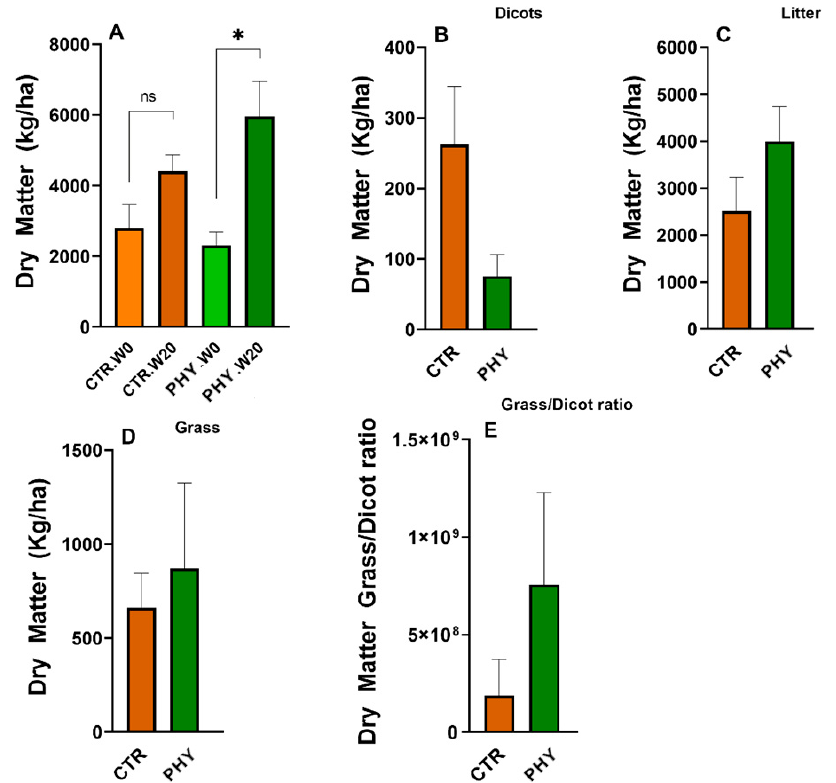
Figure 8. Dry matter differences between phytogenic liquid-treated and control plots. Panel ( A ) shows dry matter collected at week 0 and week 20. Panels ( B – D ) show dry matter collected 11 months after application. Panel ( E ) shows the grass/dicot ratio 11 months post-application. The asterisk in panel ( A ) indicates significant change ( p < 0.05), ns = not significant.